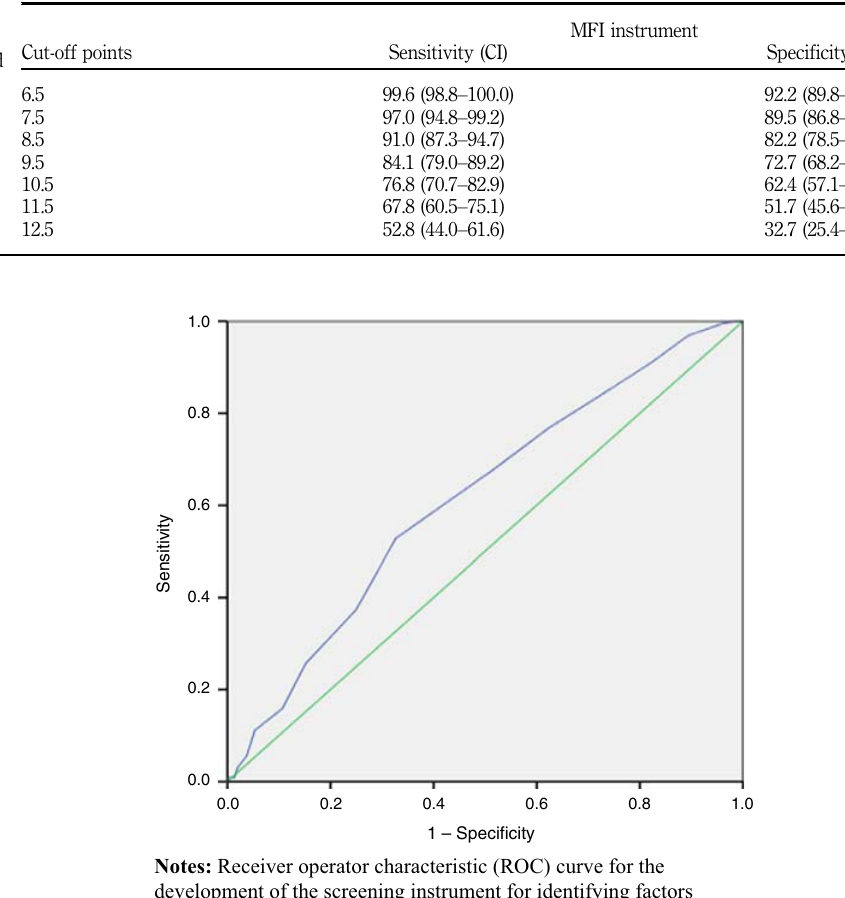
Figure 1. Distinguished ability of the predicting